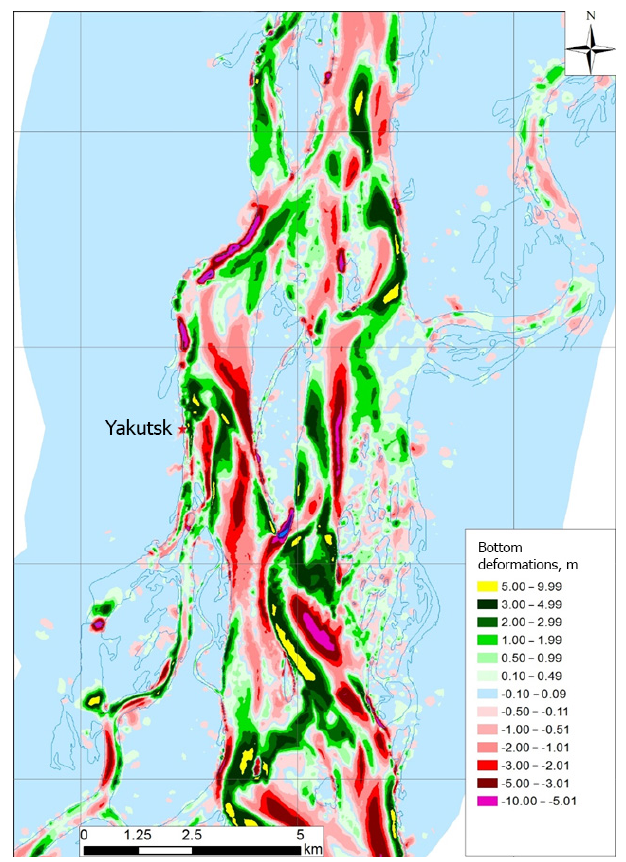
Figure 4. Simulated channel evolution near Yakutsk for the 10-year forecast